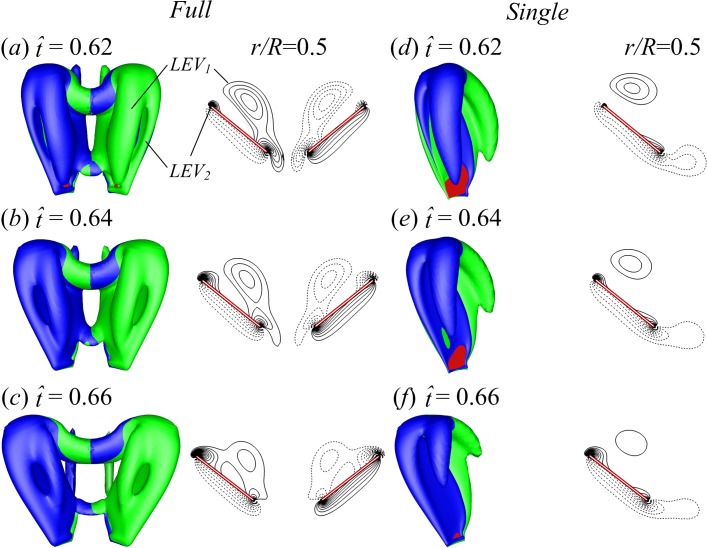
Iso-vorticity surface plots (top view; the magnitude of the non-dimensional vorticity is 3) and their corresponding spanwise vorticities (the magnitude of the vorticity at the outer contour is 2 and the contour interval is 1) at half-wing length for \documentclass[12pt]{minimal}
\usepackage{amsmath}
\usepackage{wasysym}
\usepackage{amsfonts}
\usepackage{amssymb}
\usepackage{amsbsy}
\usepackage{upgreek}
\usepackage{mathrsfs}
\setlength{\oddsidemargin}{-69pt}
\begin{document}
}{}$\hat {t}=0.62$\end{document}t ˆ=0.62, 0.64 and 0.66 of the FCF case (A–C) and SW case (D–F).Vortex structures are shaded by spanwise vorticity to indicate direction: green is negative and blue is positive.